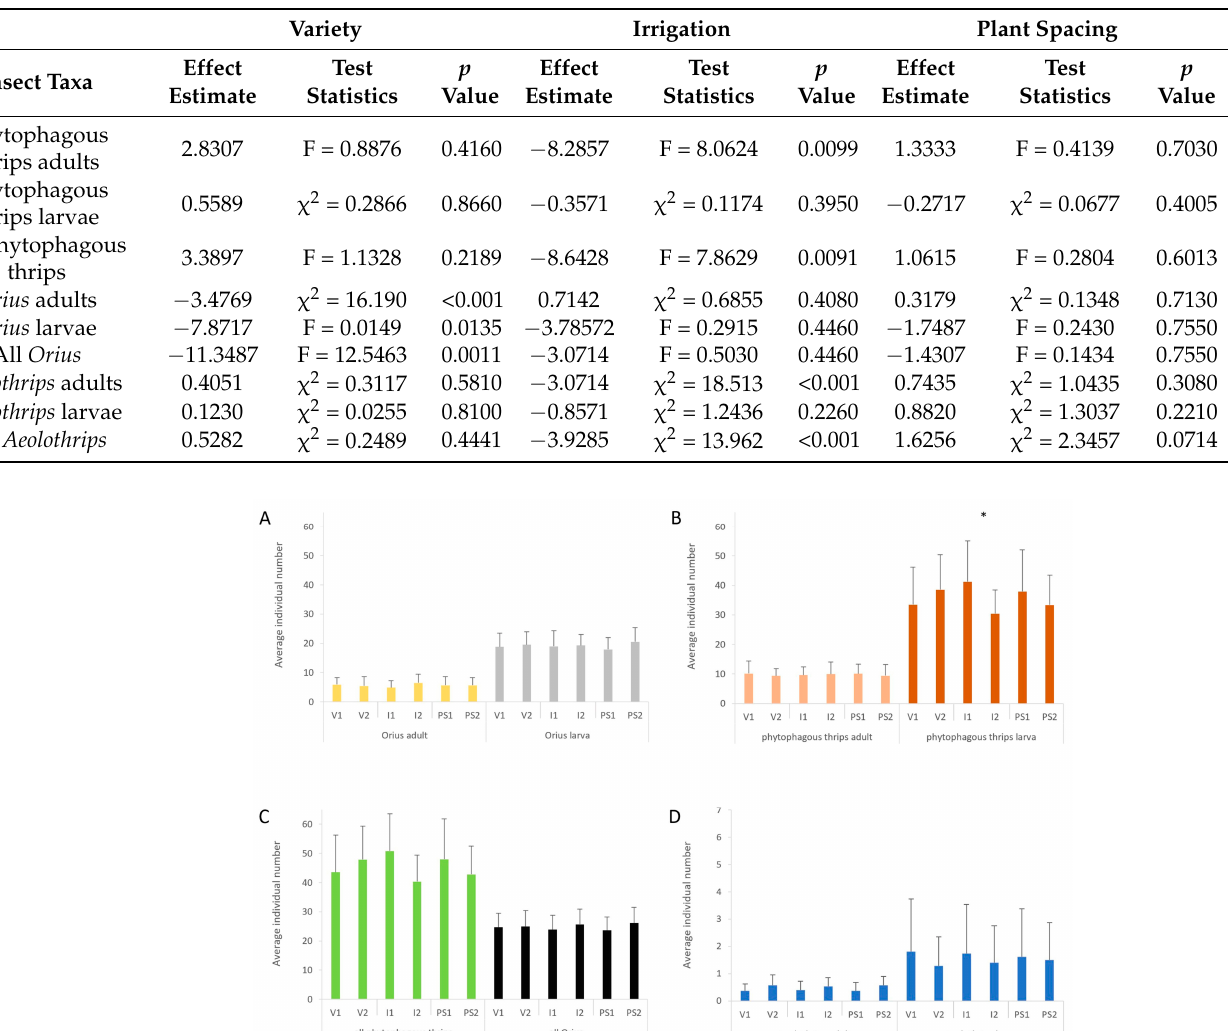
Figure 3. Average individual numbers of predatory and phytophagous insects in chili flowers under treatments in 2021: ( A ) Orius spp. ( B ) Phytophagous thrips. ( C ) All Orius and phytophagous thrips (adults and larvae). ( D ) Aeolothrips spp. (V1)Trinidad Scorpion Butch T; (V2) Yellow Scotch Bonnet; 230 (I1) Irrigation daily, 40 min; (I2) Irrigation every second day, 20 min; (PS1) Increased plant spacing; (PS2) Decreased plant spacing. * Denotes significant differences between the treatment levels ( p < 0.001). The error bars represent the standard errors.